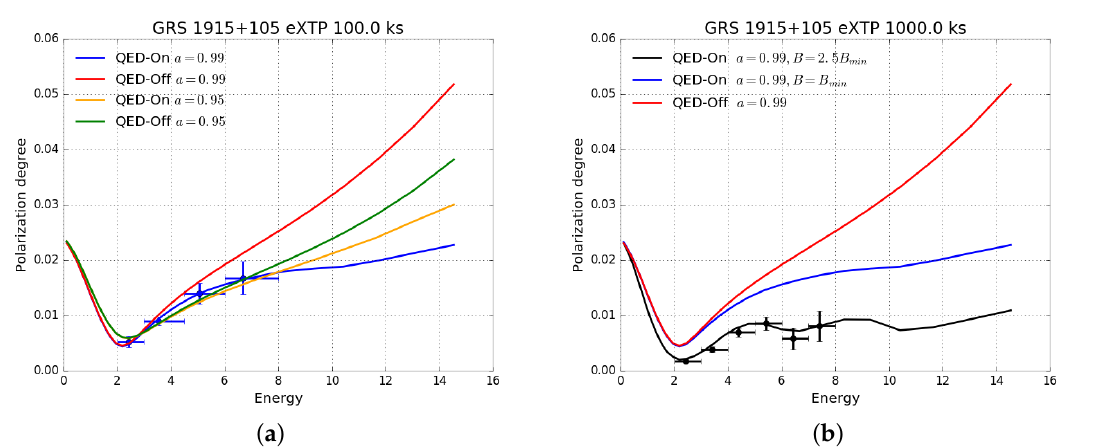
Figure 3. Observed polarization degree for the black-hole binary GRS 1915+105. ( a ) Model with a (cid:63) = 0.99 with QED (blue line) and without QED (red line); model with a (cid:63) = 0.95 with QED (yellow line) and without QED (green line). Blue dots are a simulated 100 ks observation with eXTP for the blue line model. ( b ) Model with a (cid:63) = 0.99 with QED and the minimum magnetic field (blue line) and without QED (red line); model with a (cid:63) = 0.99 with QED and 2.5 times the minimum magnetic field (black line). Black dots are a simulated 1 Ms observation with eXTP for the black line